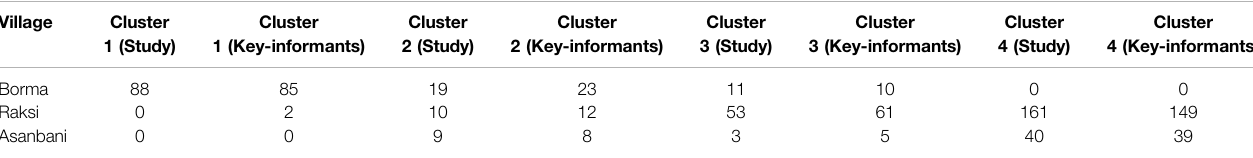
TABLE 5 | Number of individual farmers in each of the clusters identi fi ed through the study and cross-checked by the key-informants.